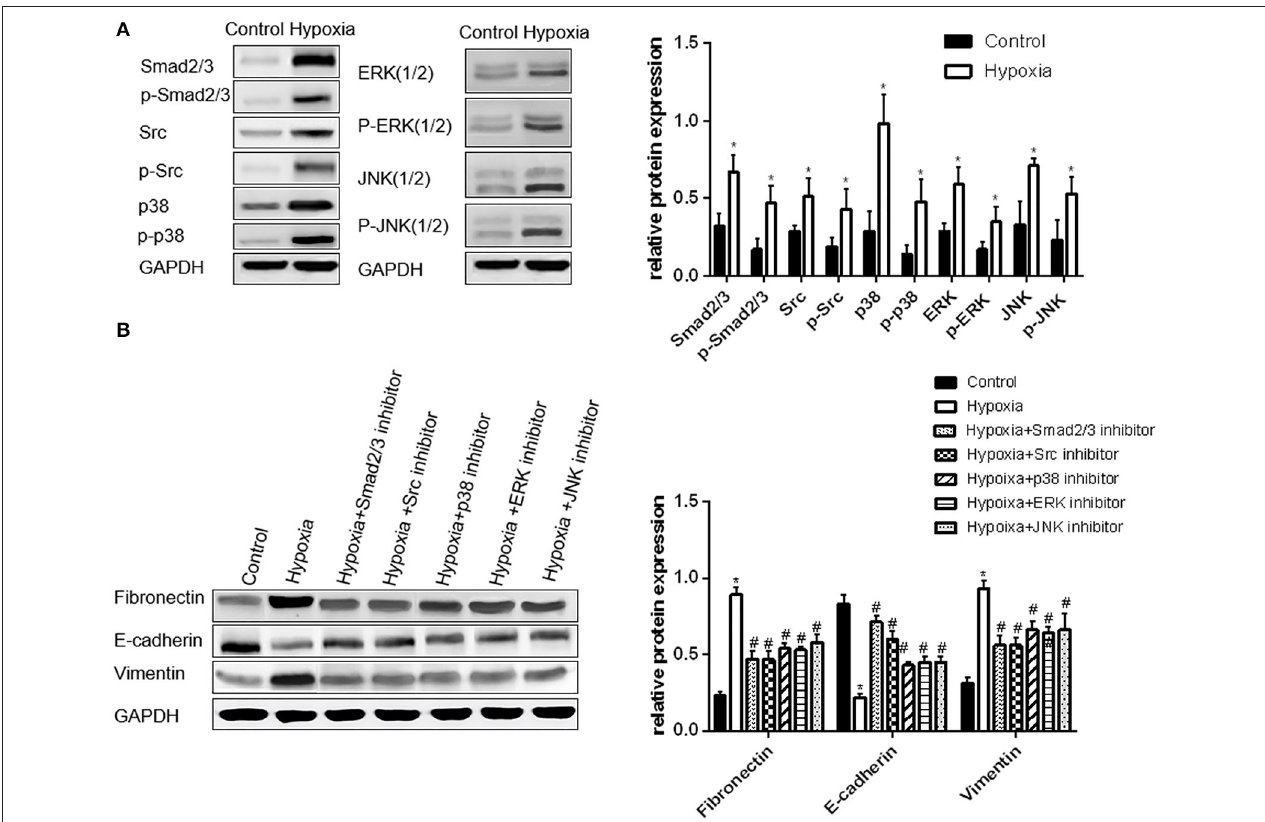
FIGURE 2 | Activation of Smad2/3, Src, p38, ERK, and JNK is important in hypoxia-induced EMT in A549 cells. (A) Smad2/3, Src, p38, ERK, JNK, and their phosphorylated forms were examined by Western blot analysis (left). GAPDH was used as internal control. The protein relative value (GAPDH) is plotted in the right panel (mean ± SD in three separate experiments). * P < 0.05, compared with A549 cells in the normal oxygen environments, the Smad2/3, Src, and MAPK proteins of A549 cells are highly regulated and activated in hypoxia environments. (B) EMT markers were examined by Western blot analysis (left). GAPDH was used as internal control. The protein relative value (GAPDH) is plotted in the right panel (mean ± SD in three separate experiments). * P < 0.05, compared with A549 cells in the normal oxygen environments, the EMT process of A549 cells under hypoxia is activated; # P < 0.05, compared with A549 cells in the hypoxia environments, the EMT process of A549 cells under hypoxia is inhibited separately by Smad2/3, Src, p38, ERK, and JNK inhibitors. The expression levels of Fibronectin and Vimentin decrease, and that of E-cadherin